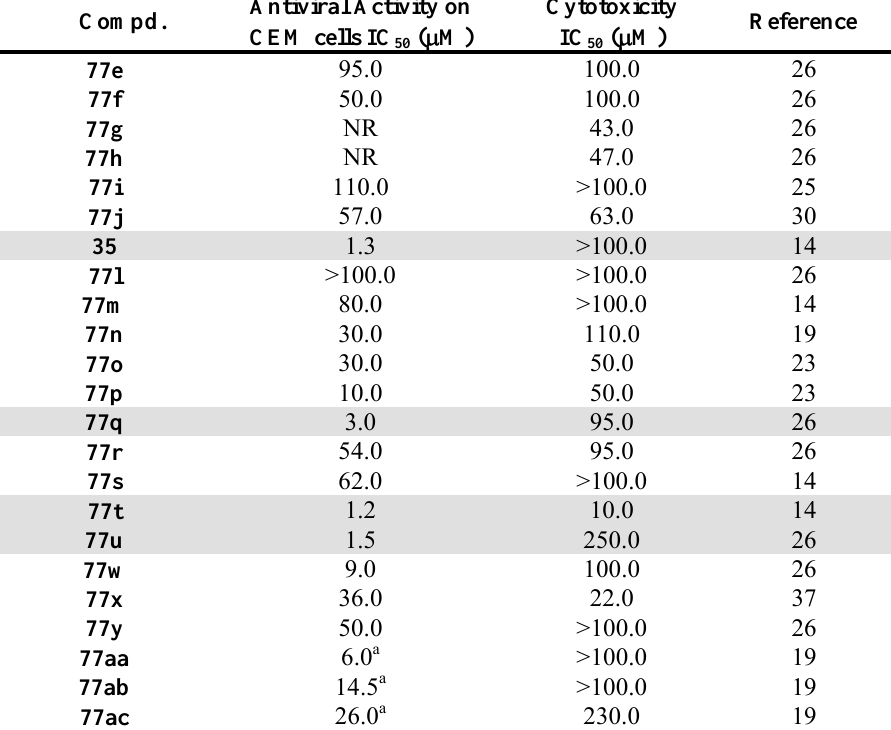
Table 11. Influence of the ancillary ring substitution on antiviral activity. Compd.